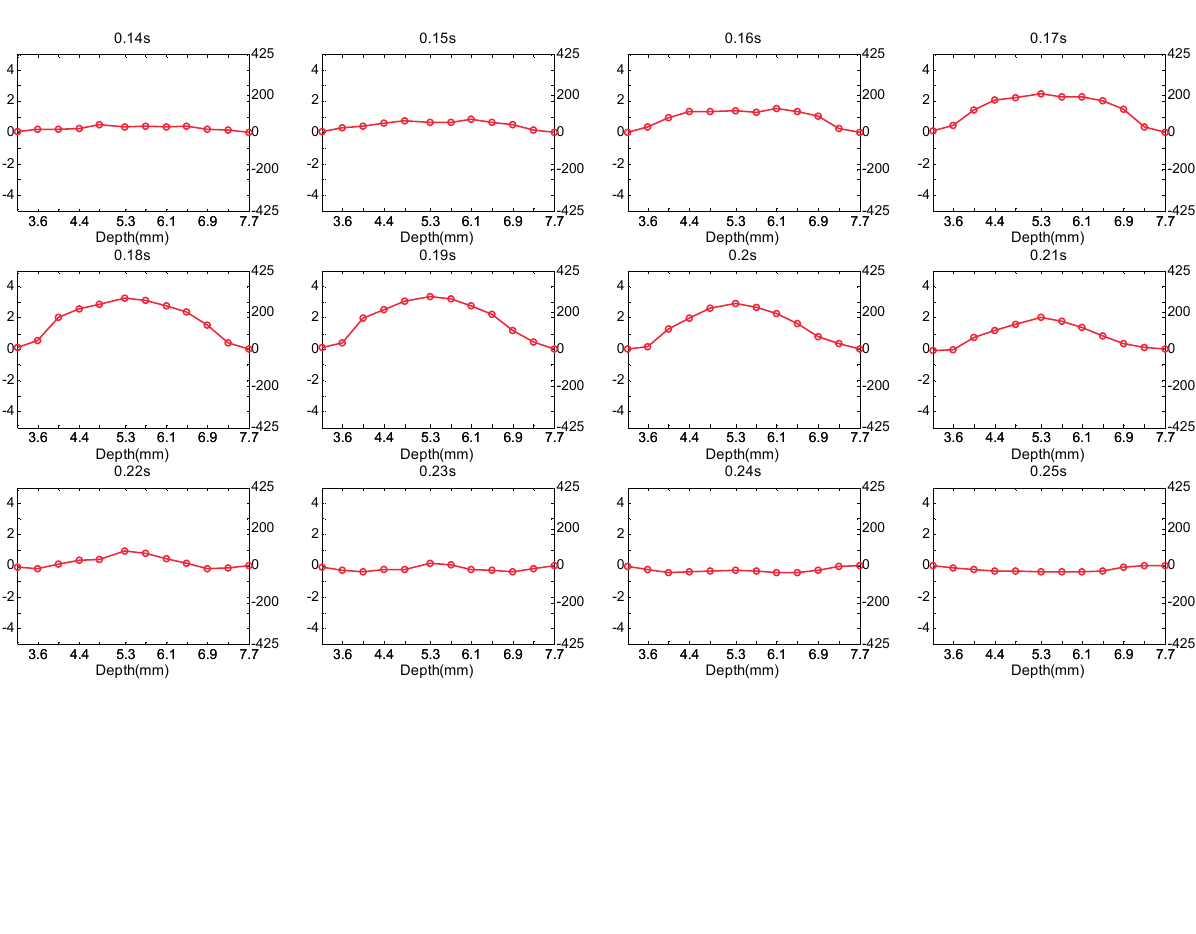
Figure 8. Velocity profile of the flow inside the vessel phantom with different time